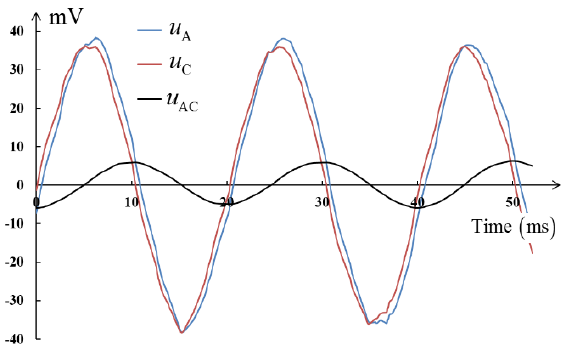
Figure 6. Time domain waveform of voltage. Table 1. U AC_rms obtained under different E 0_rms .